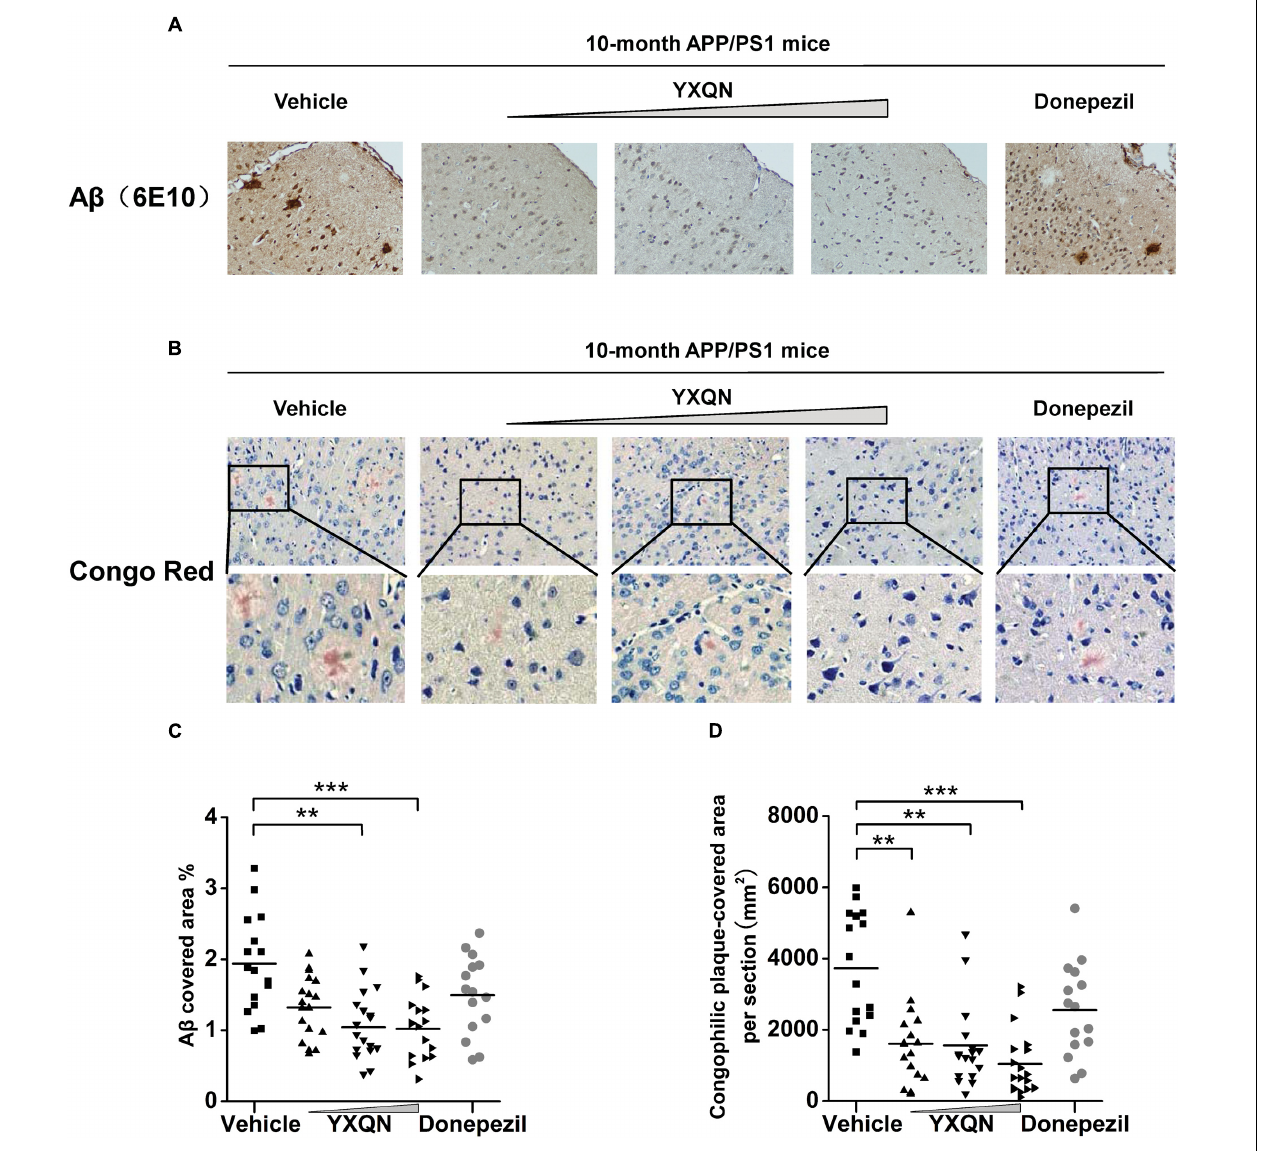
FIGURE 4 | Yangxue Qingnao reduces amyloid deposits in the brain of APP/PS1 mice. (A–D) A β plaque load in 10-month-old APP/PS1 mice after 2 months of vehicle, YXQN, and donepezil administration assessed by A β reactive antibody 6E10 (A,C) or congo red (B,D) . (A) Analysis of A β deposition levels by immunohistochemical staining in APP/PS1 mice with vehicle, YXQN or donepezil supplementation (the percent of the cover area quantified in C, n = 15–18). (B) Congo red positive plaques in groups show representative cortical areas and higher-magnification images. (D) Quantification of the cover area of